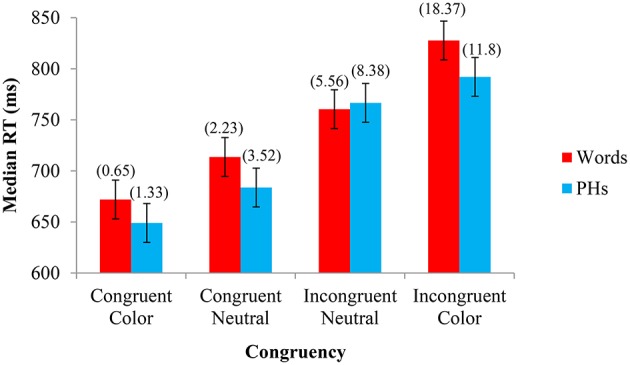
Experiment 1—Color name stimuli: Median response time (RT) and percent errors (above) in naming the font color as a function of Letter String Type (word, PHs) and Congruency (congruent, neutral congruent, neutral incongruent, incongruent). The 95% confidence intervals (shown here by the error bars attached to each data point) indicated that, for both words and PHs, there were significant differences in response time between each specific congruency condition (i.e., the RTs for congruent color, congruent neutral, incongruent neutral, and incongruent color stimuli were significantly different from each other). The percent error confidence interval was ± 2.67%. Paired-samples t-tests support the 95% CIs for Experiment 1, whereby if the CIs reflected a significant difference, so too did the t-tests, all t's(23) > 3.152, p's < 0.005.